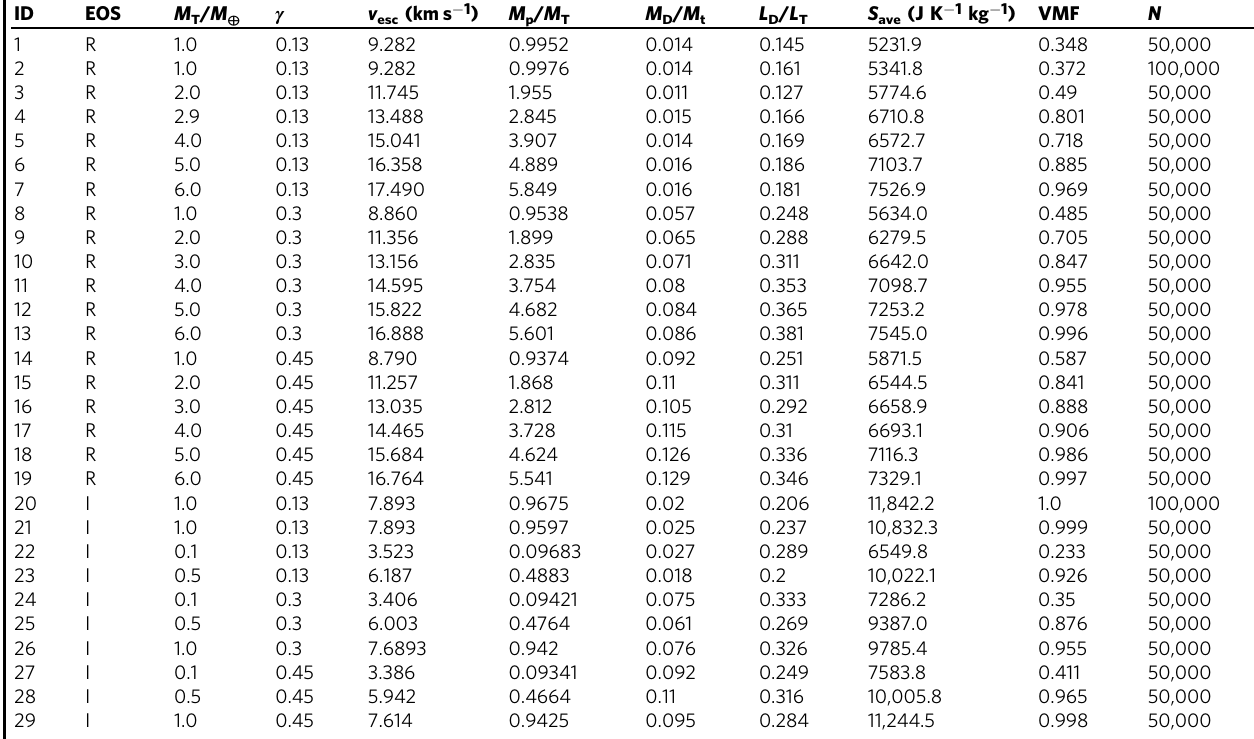
Table 1 Summary of the results.